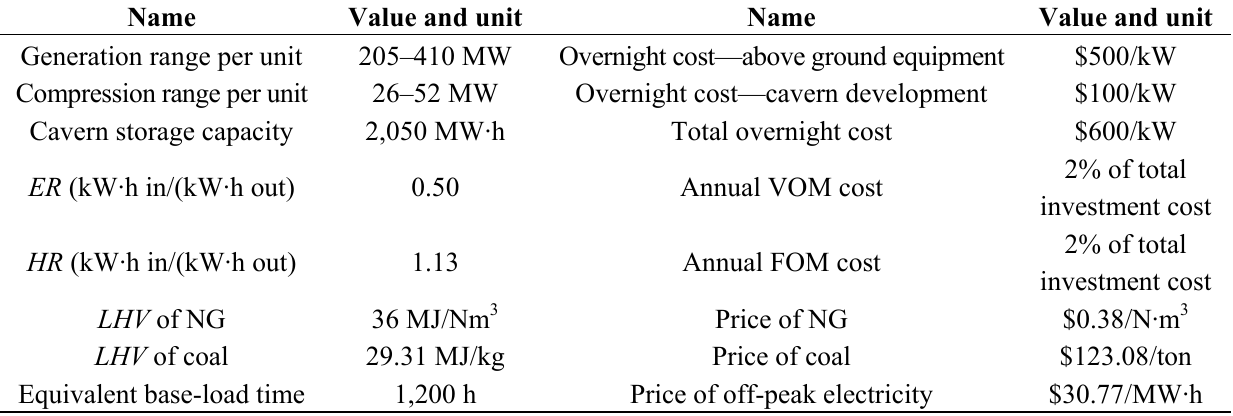
Table 7. Fundamental parameters of the hybrid-fuel 410 MW CAES plant. VOM: variable operations and maintenance; and FOM: fixed operations and